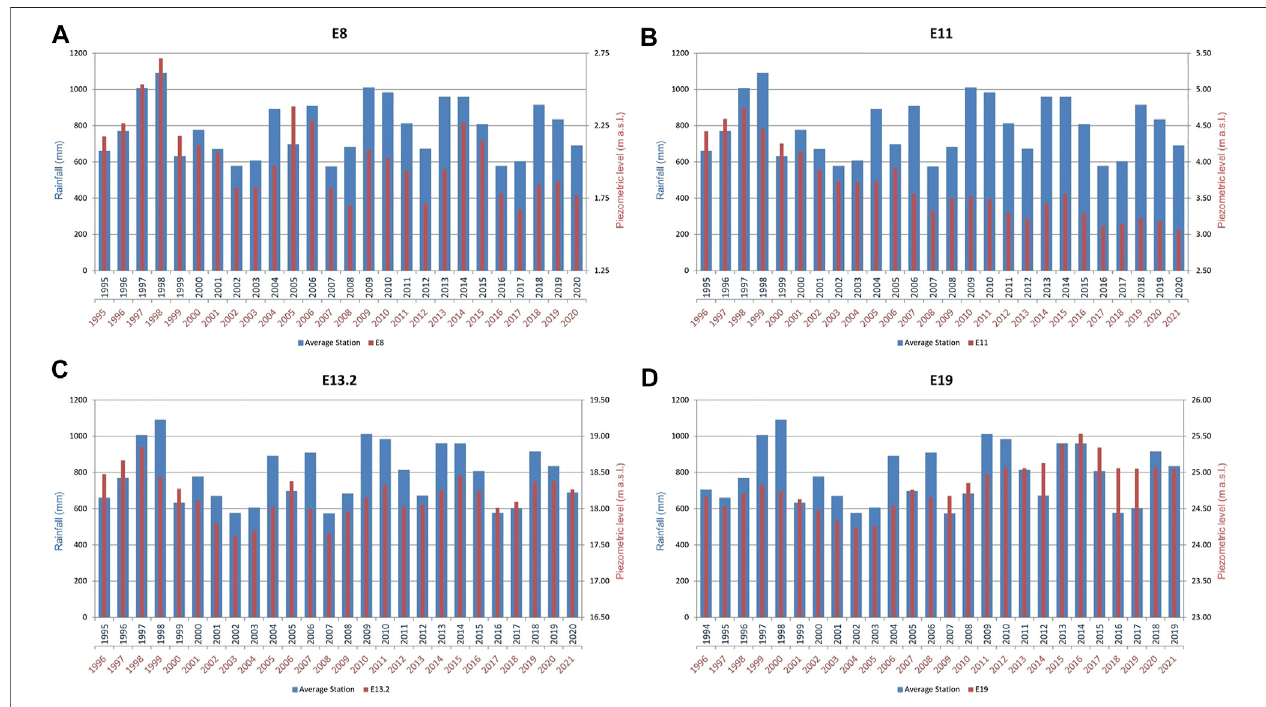
FIGURE 9 | Comparison between cumulated annual rainfall values (blue value in the x -axis) and mean annual piezometric levels (red value in the x -axis) in four representative monitoring wells: E8 [coastal area, (A) ], E11 [central area, (B) ], E13.2 [northern area, (C) ], and E19 [eastern area, (D) ].